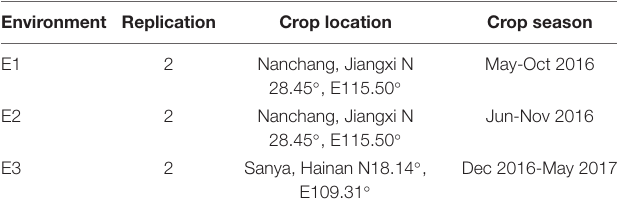
TABLE 1 | Test environments of the 132 CSSLs, CH121 and